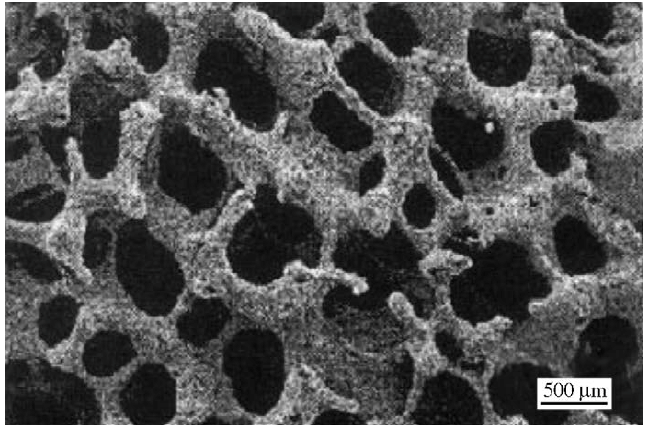
Figure 35. SEM microstructure of reticulated porous Ti-6Al-4V produced by sintering of powders deposited onto a temporary polyurethane scaffold [232]. Reprinted with